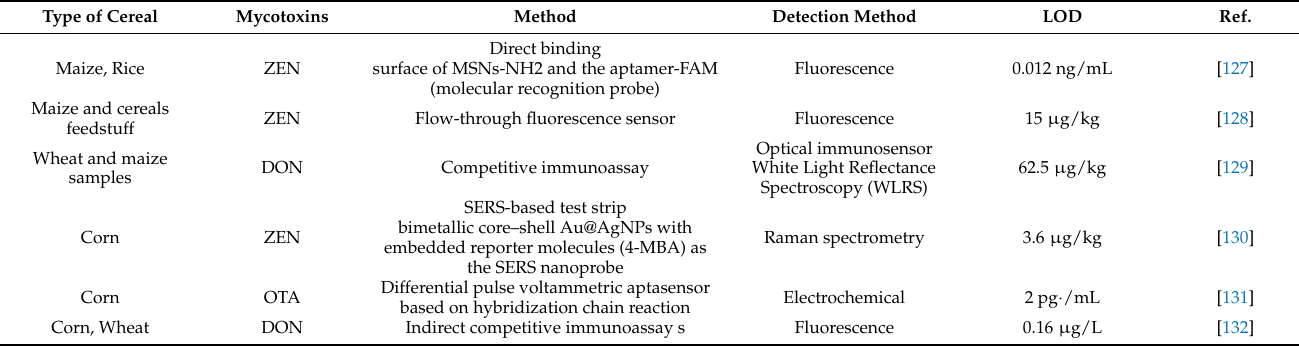
Table 3. Biosensor methods used in the analysis of